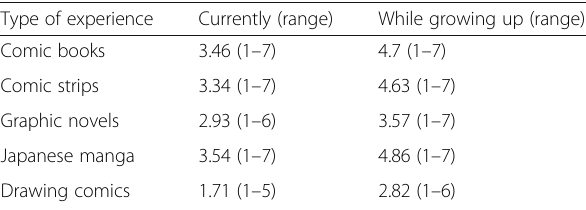
Table 1 Mean ratings for participants ’ self-assessed reading frequency for various types of visual narratives